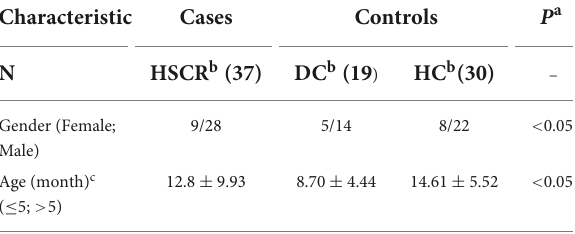
TABLE 1 Sample information of the research subjects.